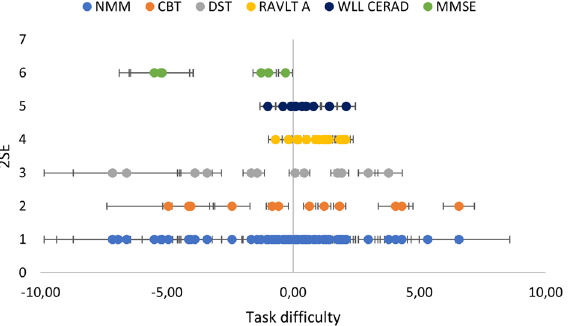
Figure 2. Each dot corresponds to each item’s task difficulty location (δ, x-axis) for the including items from the legacytests. Easiest items are located to the left and the most difficult to the right. Measurement uncertainties with coverage factor of